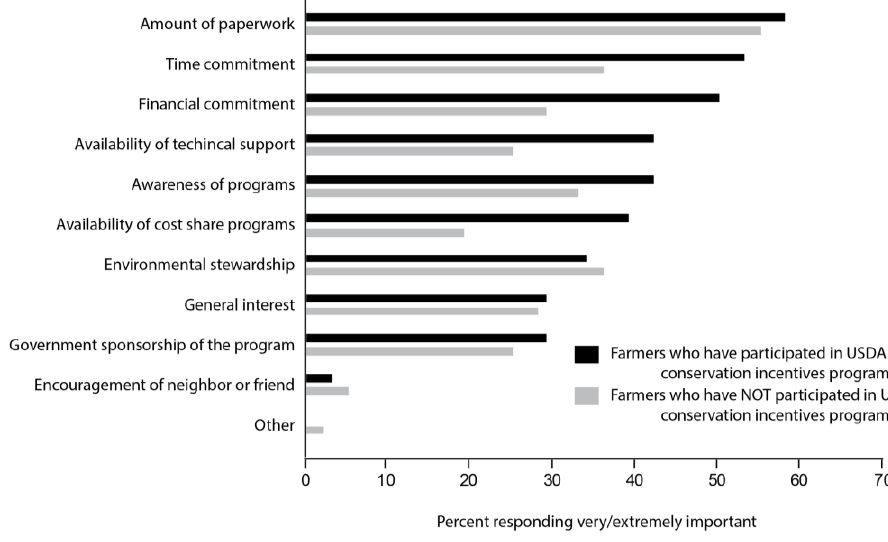
Figure 4. Percent of growers responding “very” or “extremely” to how important each factor is in their decision whether or not to participate in a conservation cost-share program (Q38).